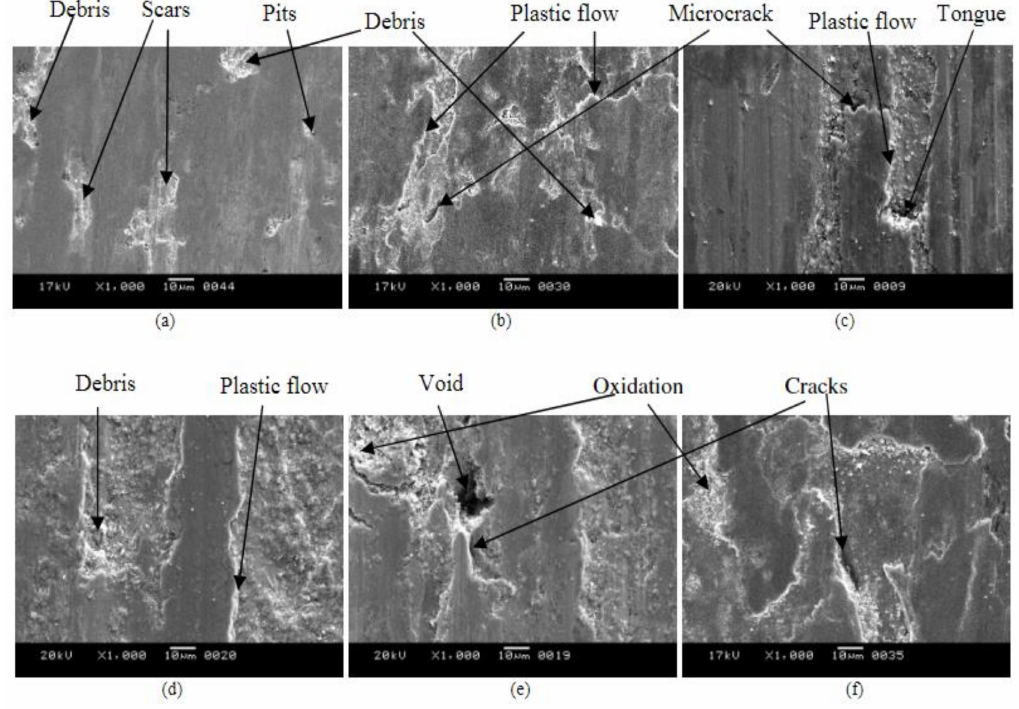
Figure 34. Worn surface micrographs of ADI samples at different austempered temperatures for 1